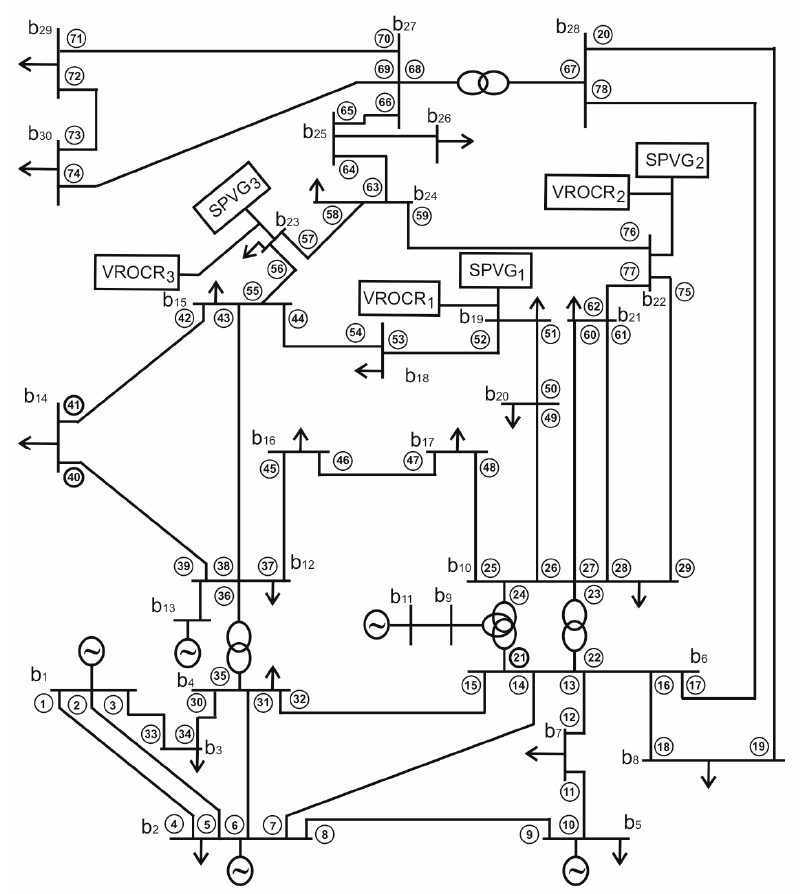
Figure 5. Diagram of three SPVGs connected IEEE 30 bus network.